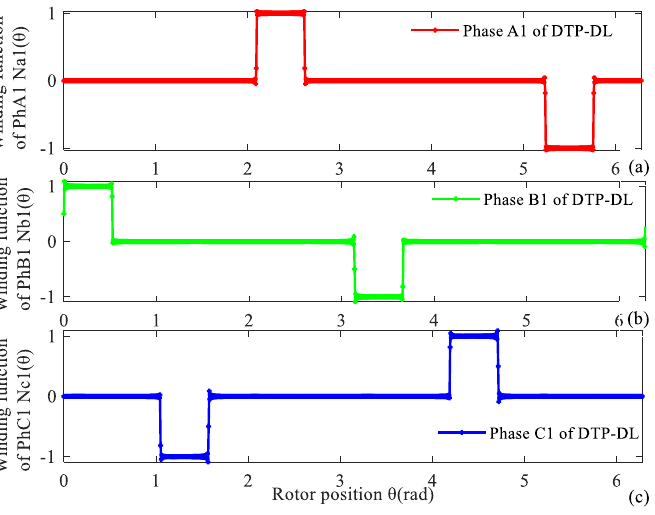
Figure 2. Winding function of first group of DTP-DL winding. ( a ) A1, ( b ) B1, ( c ) C1.